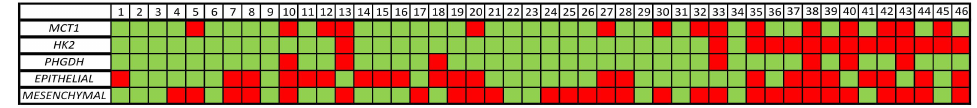
Figure 4. Heat map of epithelial markers (CK-8/CK-18/CK-19), EMT markers (VIM/TWIST-1) and MRGs (HK2/PHGDH/MCT1) as quantified by RT-qPCR. The red color represents overexpression, while the green color represents under expression or a lack of expression. The heatmap shows samples grouped by batch based on their positivity for